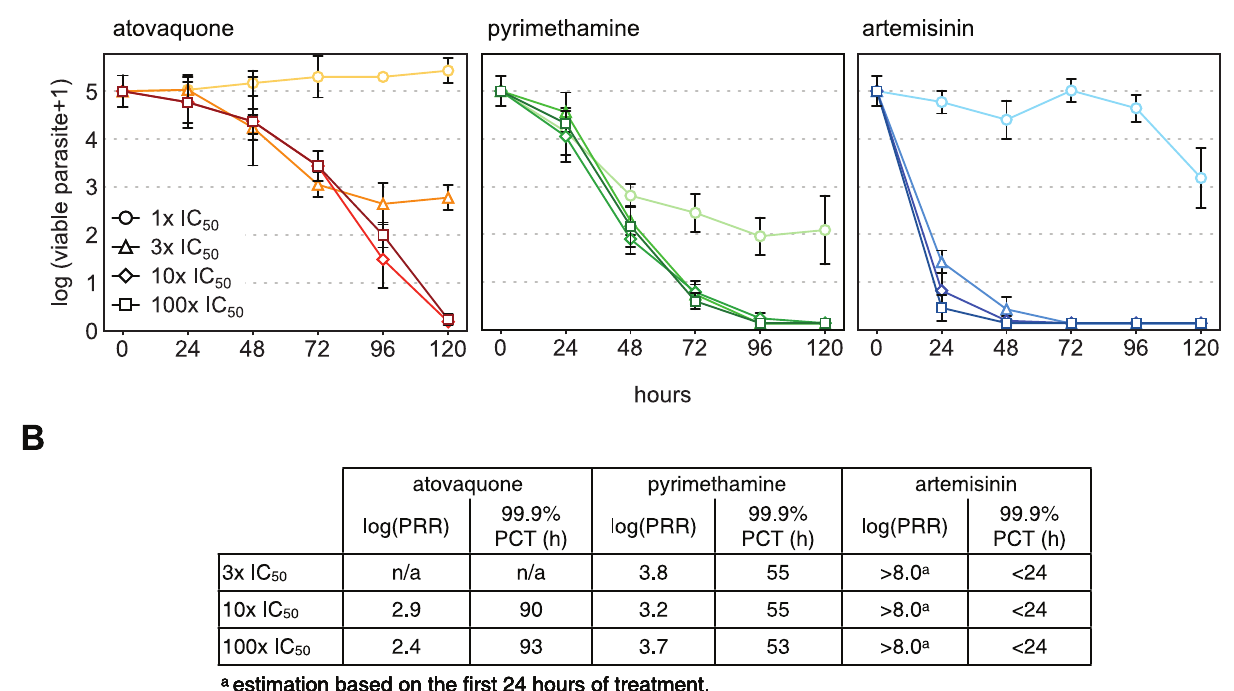
Figure 4. Parasite viability time-course in response to various concentrations of drugs. A . P. falciparum viability time-course profiles for atovaquone, pyrimethamine, and artemisinin at concentrations corresponding to 1 6 , 3 6 , 10 6 , and 100 6 their respective IC 50 . Error bars are SEM of at least 4 independent experiments. B . Values represented in panel A. No PRR or 99.9% PCT could be calculated for the 1 6 IC 50 conditions.